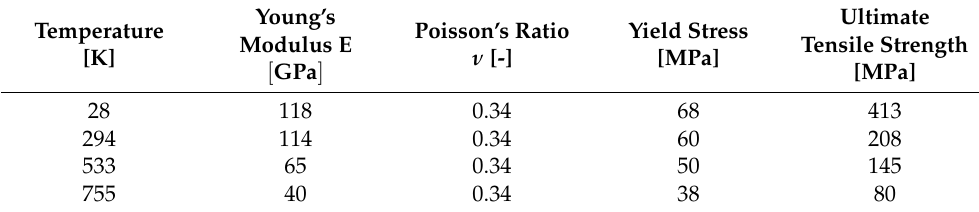
Table 4. Physical properties of electrodeposited OFHC.